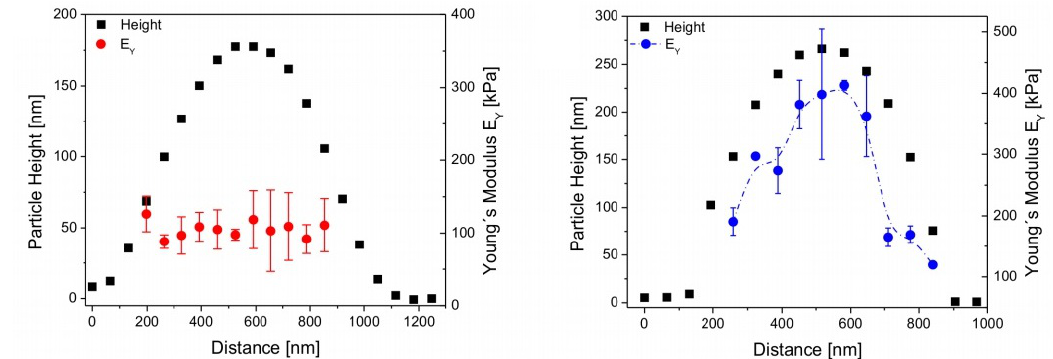
Figure 4. Particle heights and the corresponding Young’s moduli versus the particle cross section of cross-linker-free microgels ( left ) and microgels with 5mol% cross-linker ( right ). Taken from [28]. Cross-linker-free microgels: One possibility to reduce the radial density gradient within microgels is to synthesise self-crosslinked PNIPAM microgels without addition of a cross-linker [61–63]. This